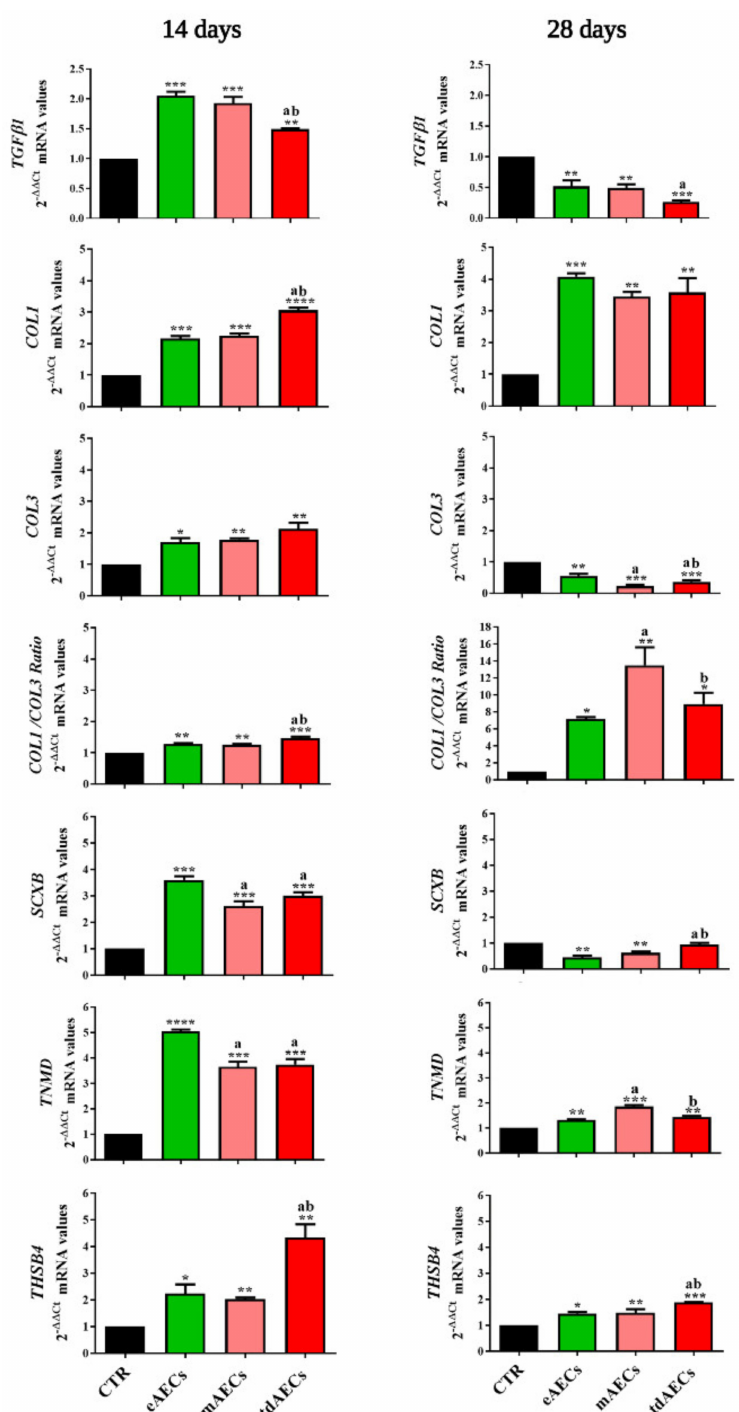
Figure 4. Gene expression profile of ECM and tendon-related genes in explanted tendons. Gene expression profile of TGF β 1, COL1, COL3, SCXB, TNMD, and THSB4 in CTR (black), eAECs (green), mAECs (light red), and tdAECs (red)-treated tendons at 14 and 28 days after cells’ transplantation. Values were considered statistically significant for * p < 0.05, ** p < 0.01, *** p < 0.001, **** p < 0.0001 vs. CTR, a p < 0.05 vs. eAECs, b p < 0.05 vs. mAECs. The quantitative data were expressed as mean ±